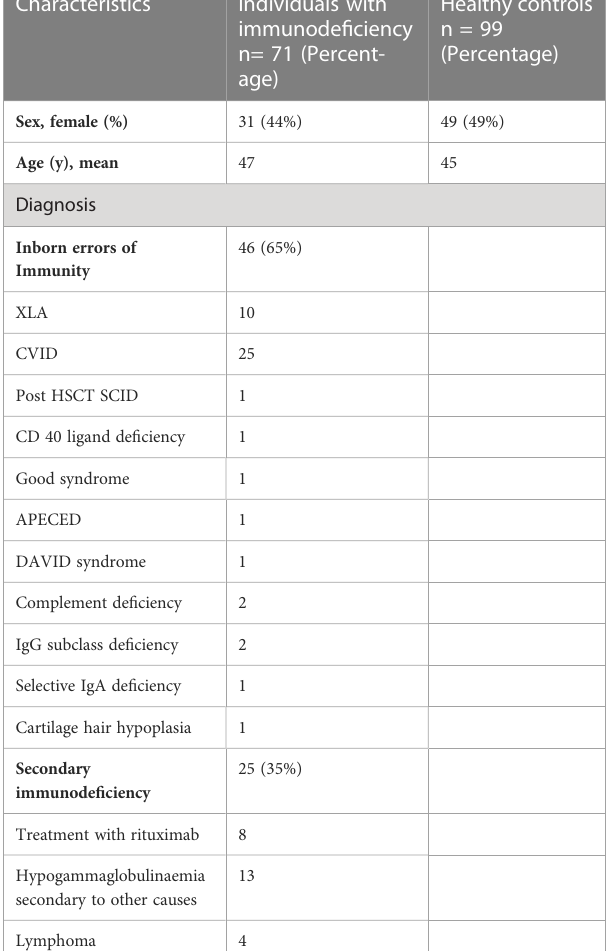
TABLE 1 Patient characteristics.